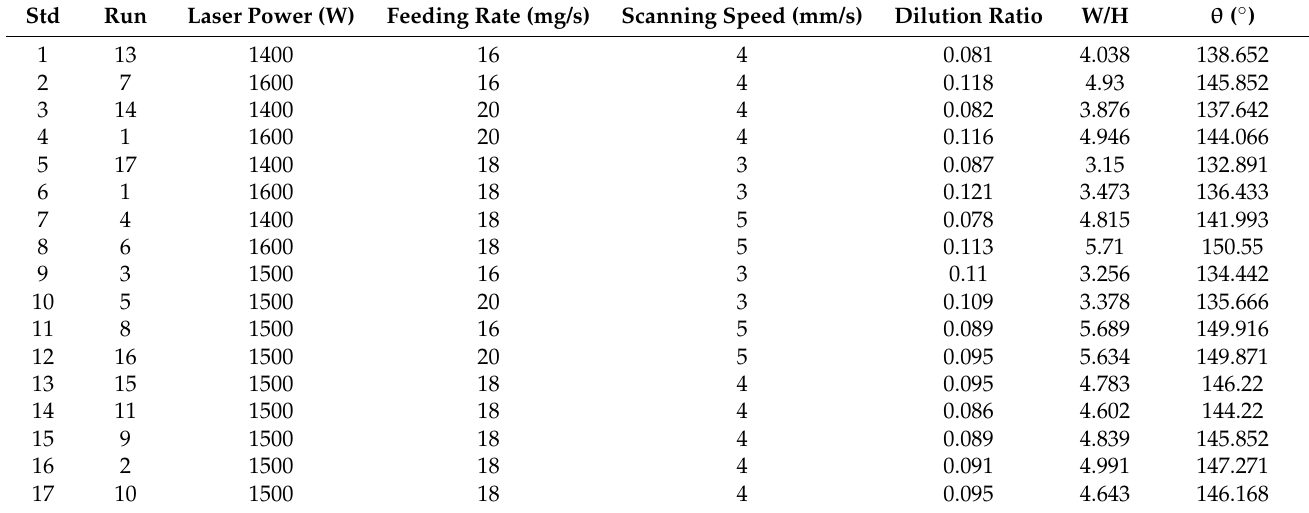
Table 4. BBD experimental designs and results.